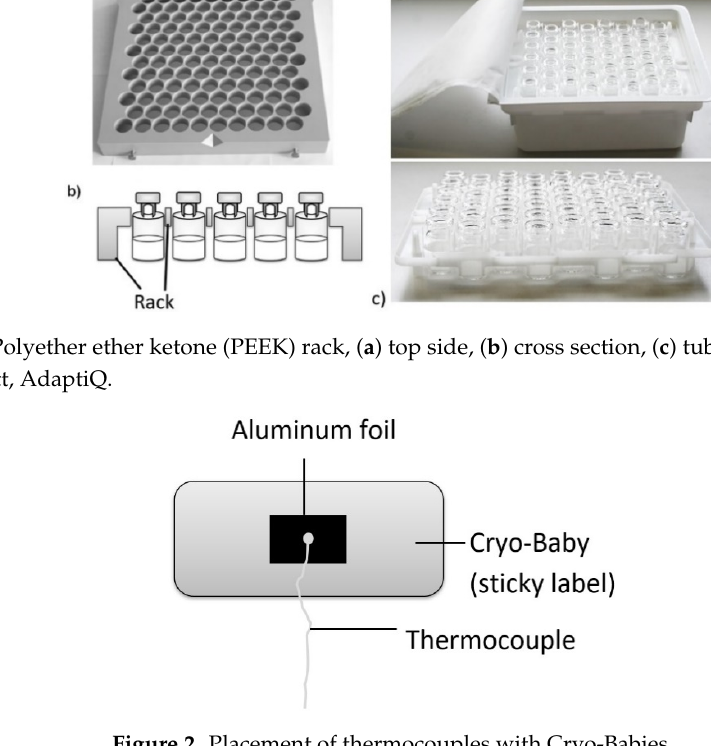
Figure 2. Placement of thermocouples with Cryo-Babies.